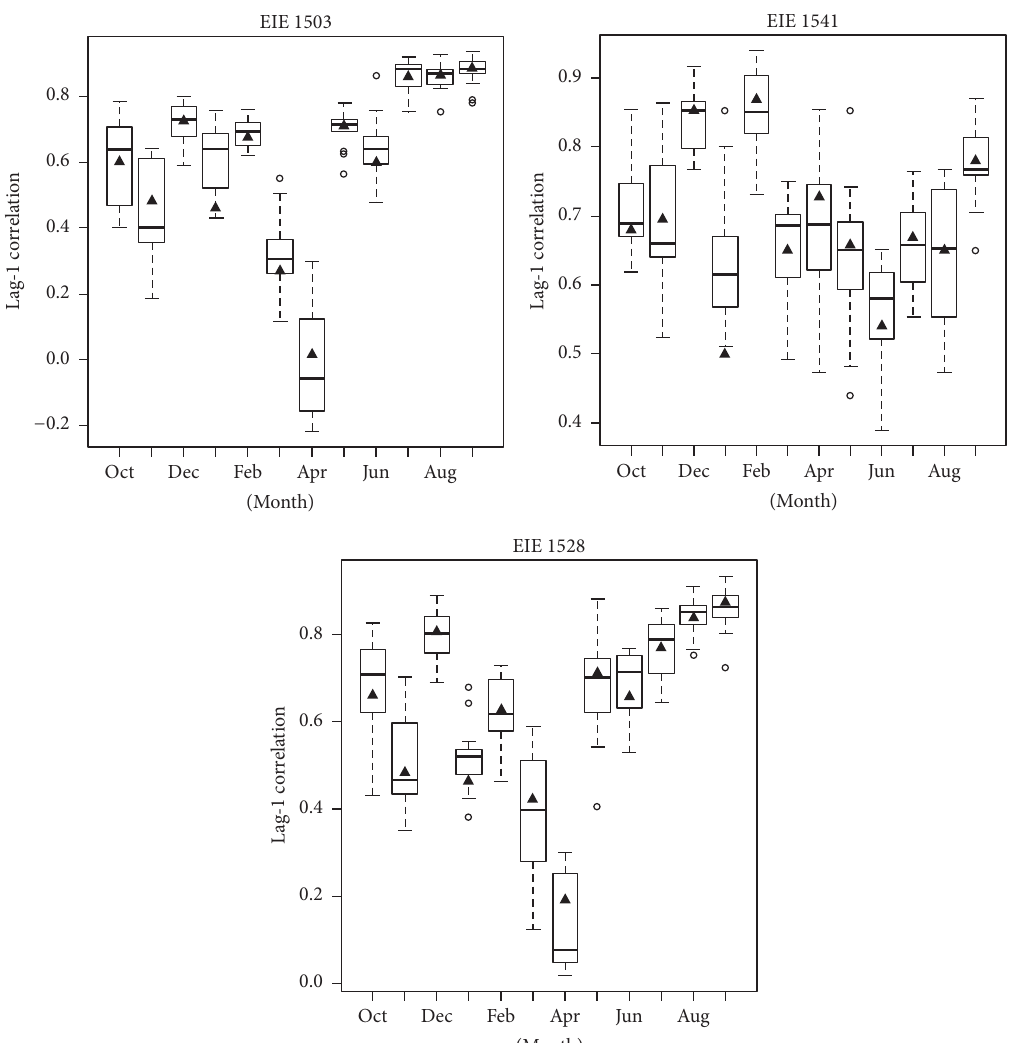
Figure 9: Simulated and observed lag-1 values from all stations. The triangle denotes the observed